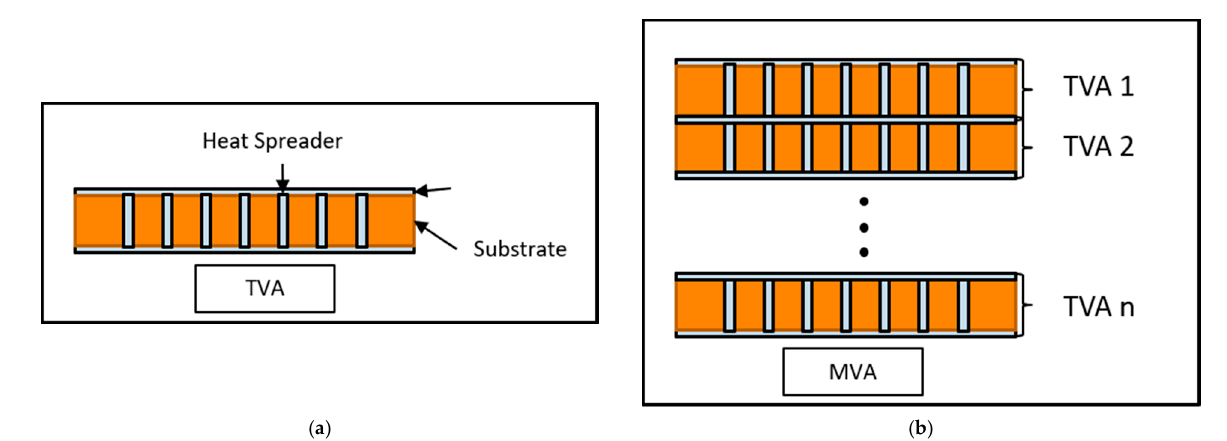
Figure 1. A generalized schematic of ( a ) TVA and ( b ) MVA. As can be seen, an MVA in its most simple form is a stack of N-many TVAs.